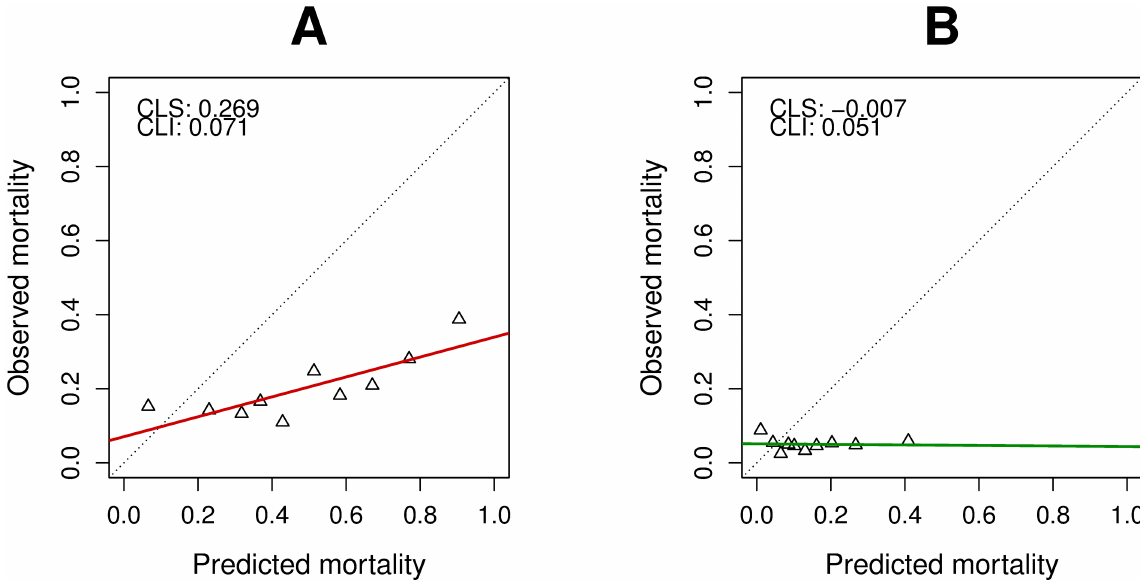
Fig 2. Calibration plots comparing observed and predicted mortality. Plots for the validation sample are shown for (A) within 30 days and (B) within 24 hours. Abbreviations: CSL: Calibration line slope, CLI: Calibration line